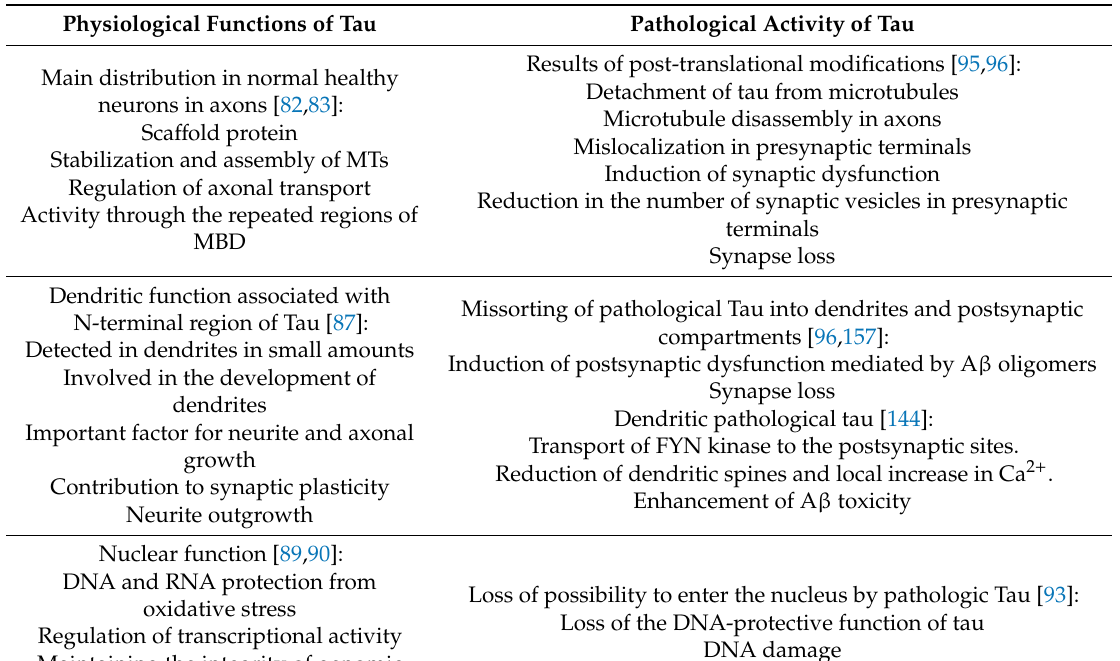
Table 2. Functions of normal Tau and toxic activity of pathological forms of